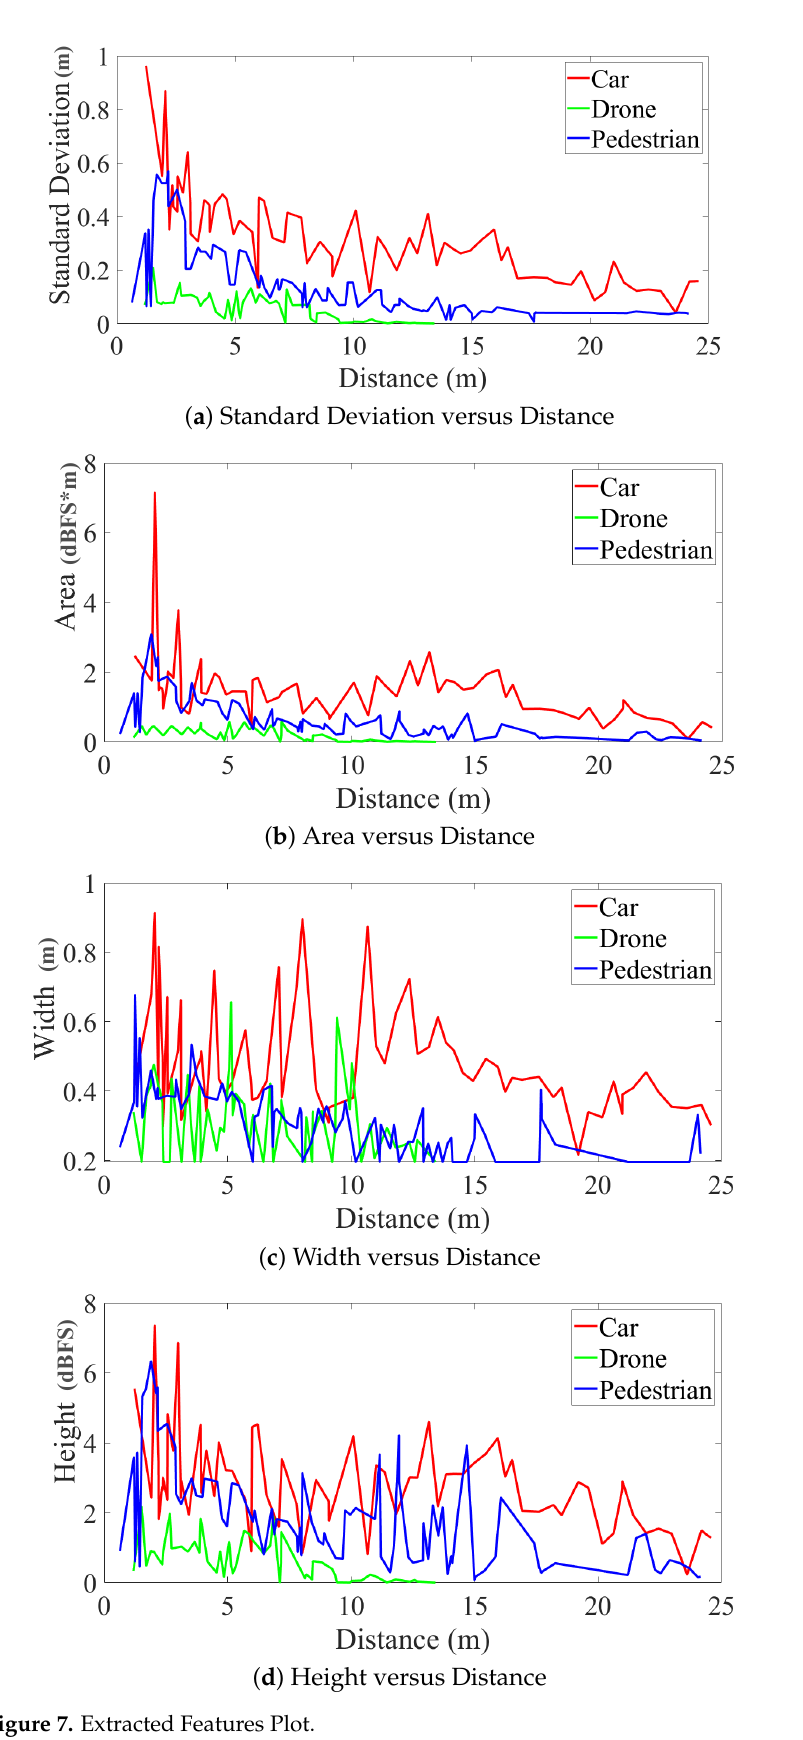
Figure 7. Extracted Features